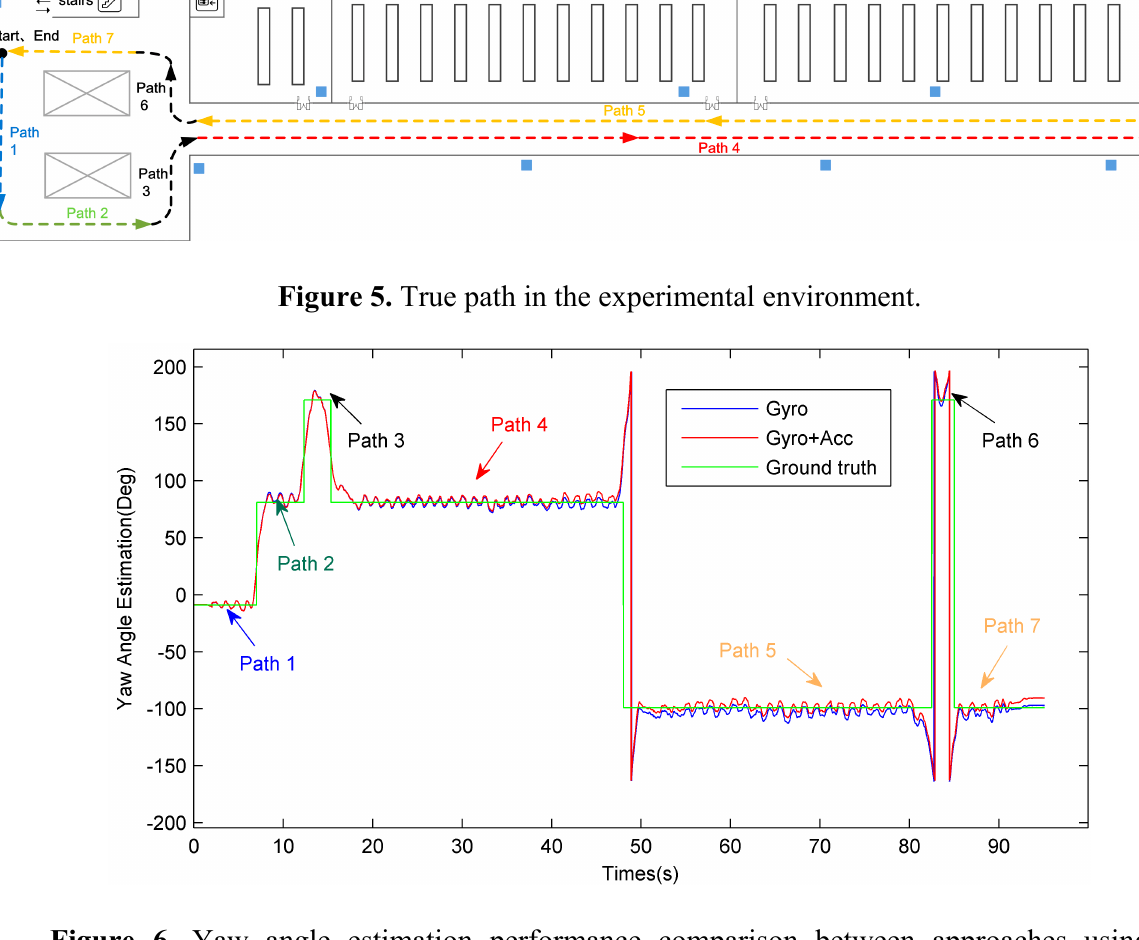
Figure 6. Yaw angle estimation performance comparison between approaches using gyroscope only and combining gyroscope with